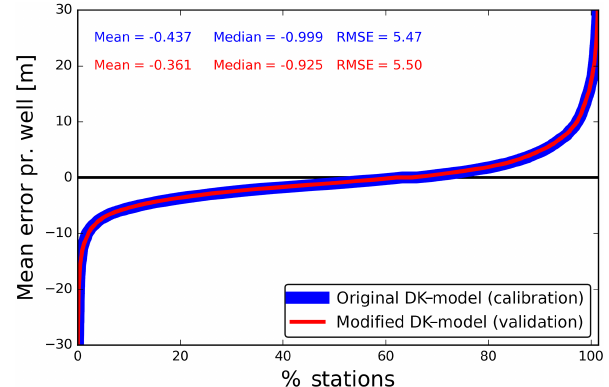
Figure 13. The figure shows the error and statistics in the ground- water heads estimated from the original DK-model and the modi- fied version of the DK-model. Stations have been ranked by perfor- mance and presented on the horizontal axis as a